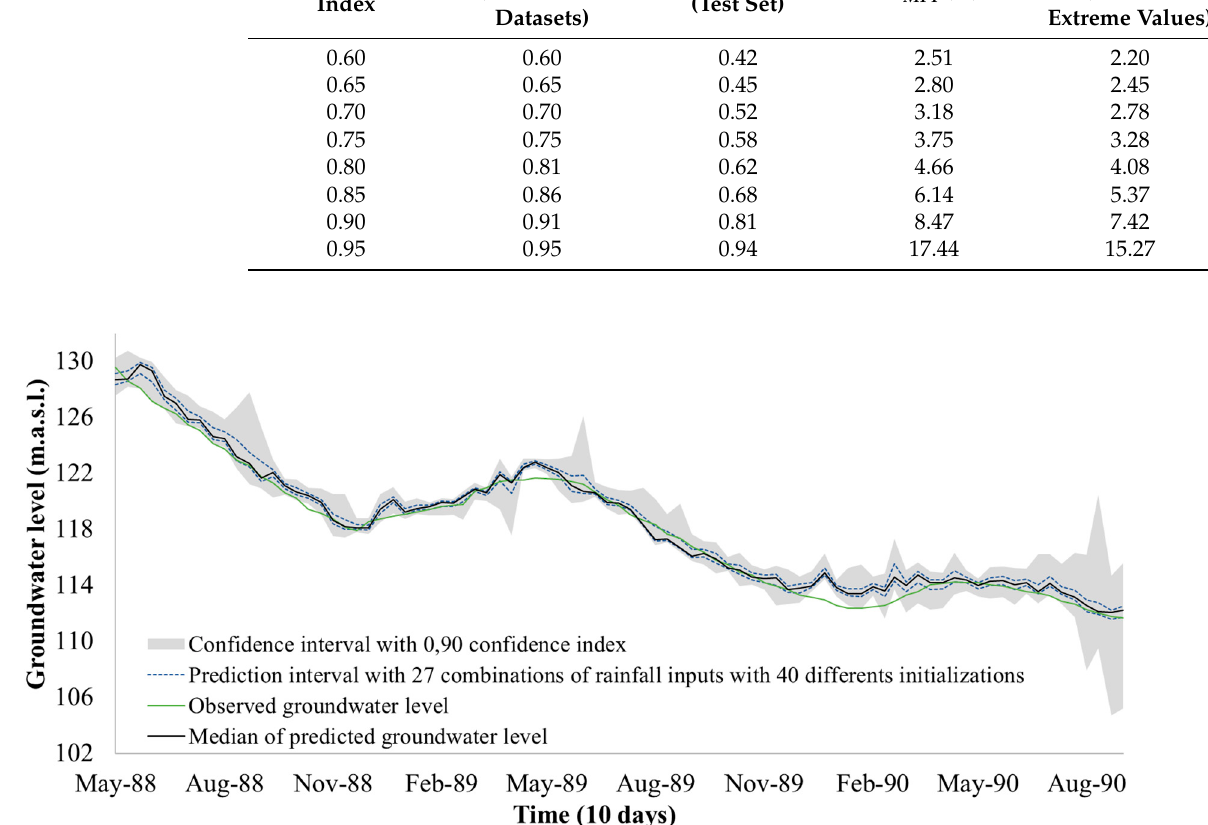
Figure 13. Groundwater level forecasting for 20 days’ lead-time and confidence interval calculated with 0.90 confidence index. C p = 0.40; C PICP = 0.81; C MPI = 8.47 m.